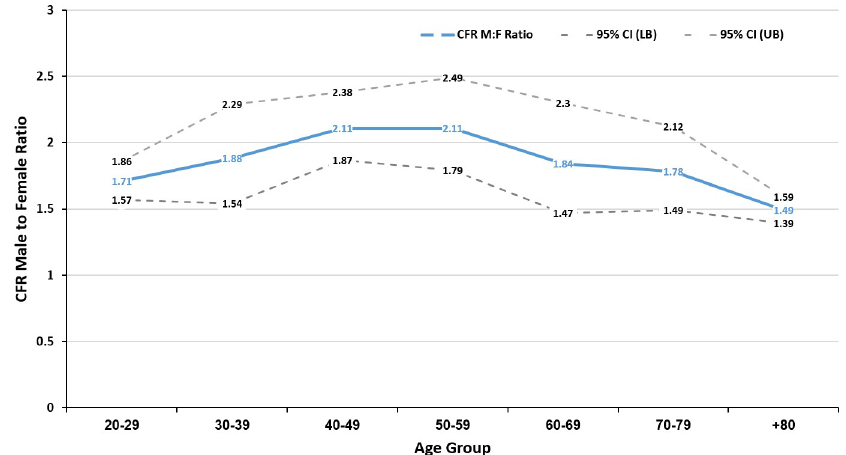
https://doi.org/10.1371/journal.pone.0250523.g003